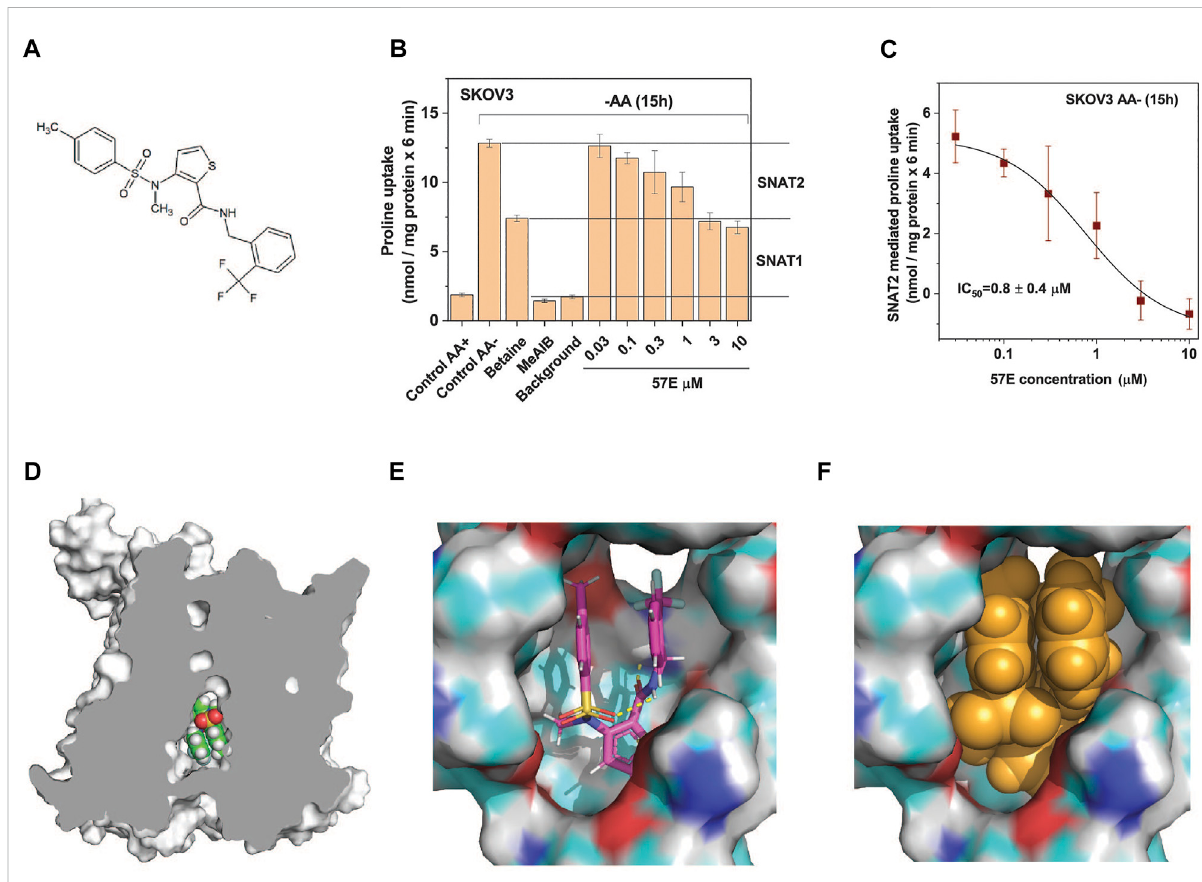
FIGURE 5 Compound 57E is a high-af fi nity SNAT2 inhibitor. (A) Chemical structure of compound 57E. (B) SKOV3 cells were pre-incubated in starvation medium for 15 h to induce SNAT2 expression (control AA-) or remained in full growth medium (control AA+). Compound 57E was assayed at different concentrations for its effect on the uptake of 100 µM proline compared to the effect of betaine (10 mM) and MeAIB (10 mM). Contribution of SNAT1 and SNAT2 to proline transport are indicated in the margin. Background activity was measured as the uptake of radioactive proline in the presence of 10 mM unlabelled proline. (C) Data from panel B were used to determine the IC 50 of compound 57E on proline transport after subtraction ofthebetaineresistantprolinetransport. (D) Dockingofcompound57EwasperformedusingahomologymodelofSNAT2basedonthe structure of Danio rerio SNAT9. (E) Compound 57E folding up to bind to the cavity of SNAT2. (F) Space- fi ll depiction of compound 57E in the proposed binding